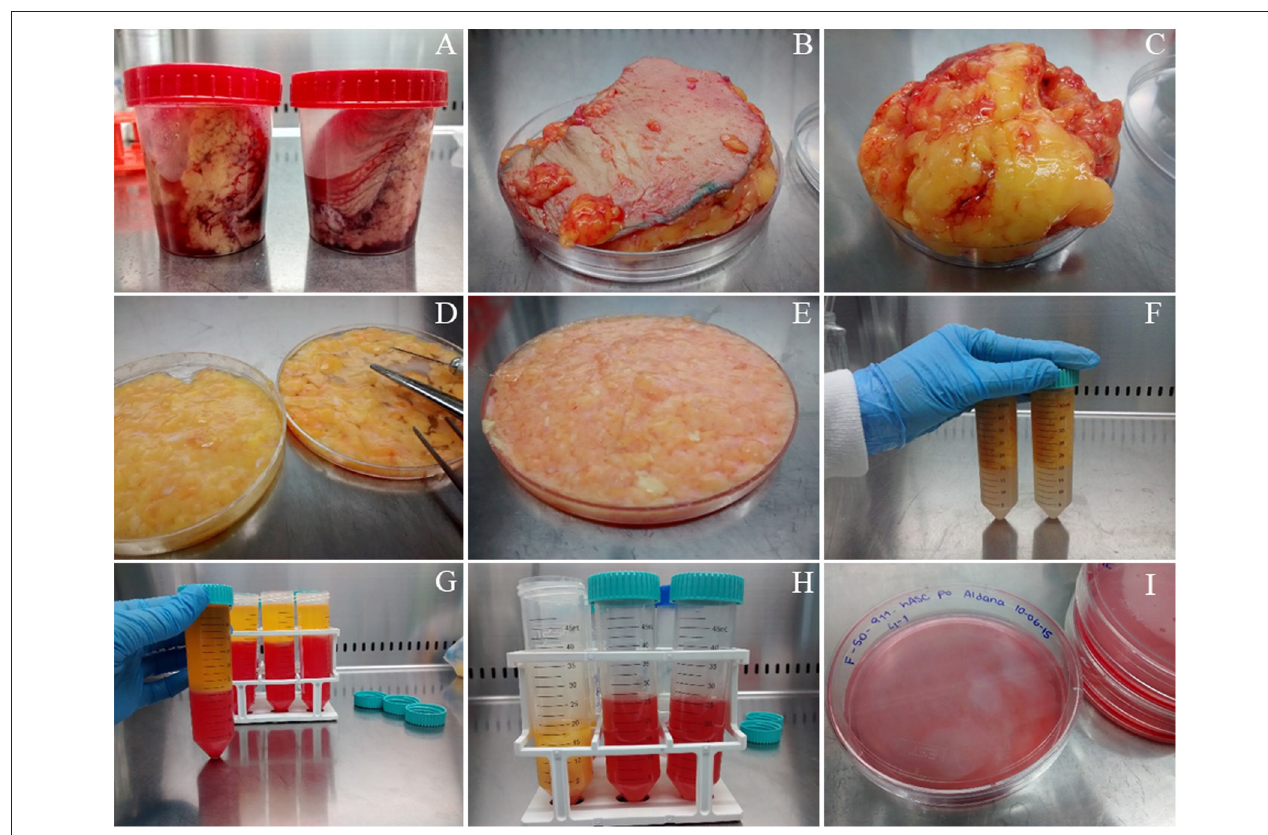
FIGURE 1 | Isolation of mesenchymal stem/stromal cells from human solid adipose tissue . (A) solid white adipose tissue samples are received in 120mL disposable sterile plastic containers, (B) the samples are placed on a Petri dish before starting their dissection, (C) fat is separated from skin (which is discarded), (D) fat tissue is cut with scissors, (E) fat is cut further with surgical blades, (F) fat is rinsed with PBS buffer in polypropylene conical tubes, (G) obtaining of three phases after filtration and centrifugation, (H) separation of the stromal vascular fraction (SVF) from the other two phases, (I) seeding the washed SVF in 10cm diameter plate with supplemented